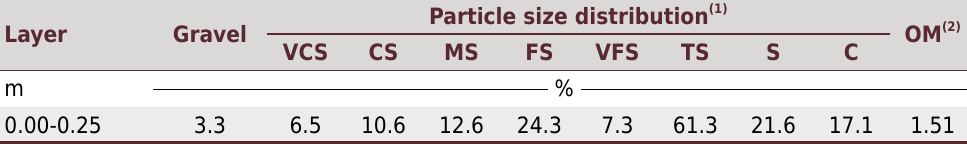
Table 1. Particle size analysis of soil with different classes of sand, silt, and clay, organic matter content, and texture (adapted from Souza, 1976) Particle size distribution Layer Gravel